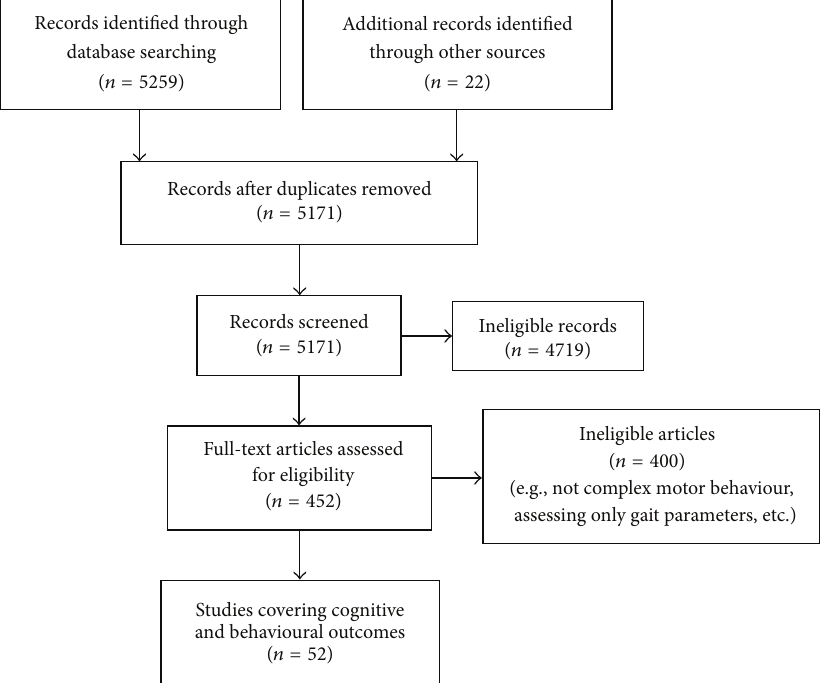
Figure 1: Flow diagram of the study selection